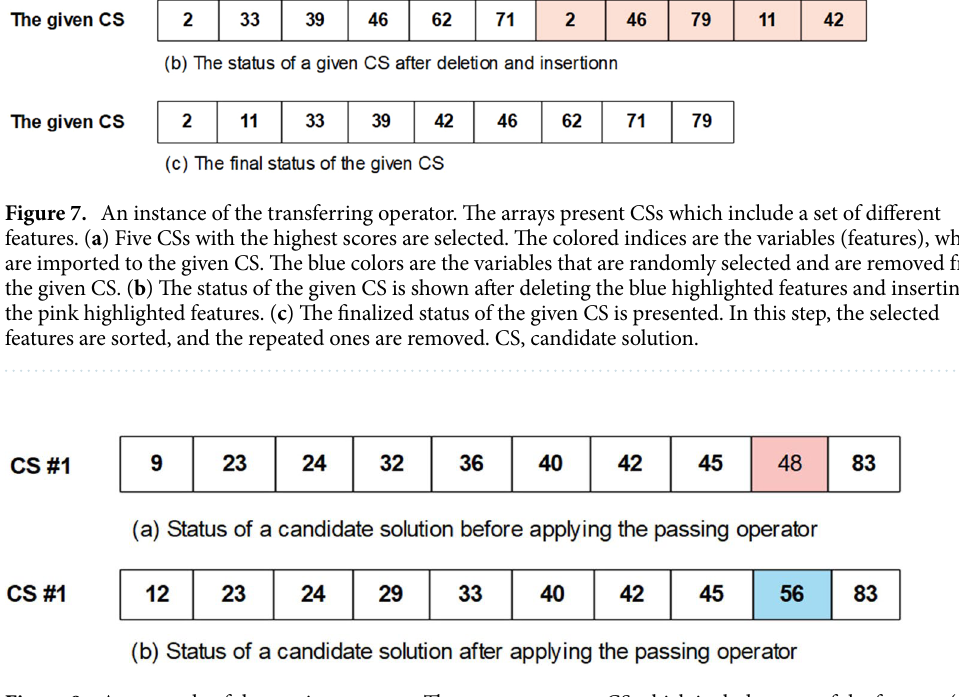
Figure 8. An example of the passing operator. The array presents a CS which includes a set of the features ( a ) The status of a CS before applying the passing operator is presented. One of the features has been randomly selected. ( b ) The status of the CS after applying the passing operator. The determined feature has been replaced by another feature. CS, candidate